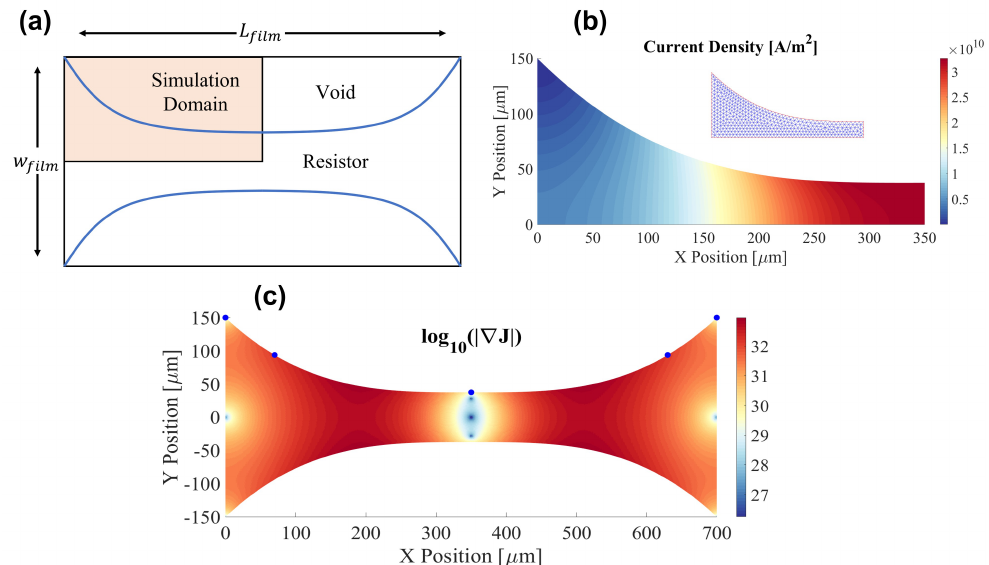
Figure 2. Spline-Based Resistor Topology Optimization—illustrates the resistor design optimization process to minimize thermal stresses using the placement of spline knot points. ( a ) design domain showing exploitation of symmetry in simulation region, ( b ) computational mesh and finite element solution for the current density magnitude || J || , and ( c ) logscale contour plot of ||∇ J || used to define resistor fitness on optimized designs (sample spline knot points